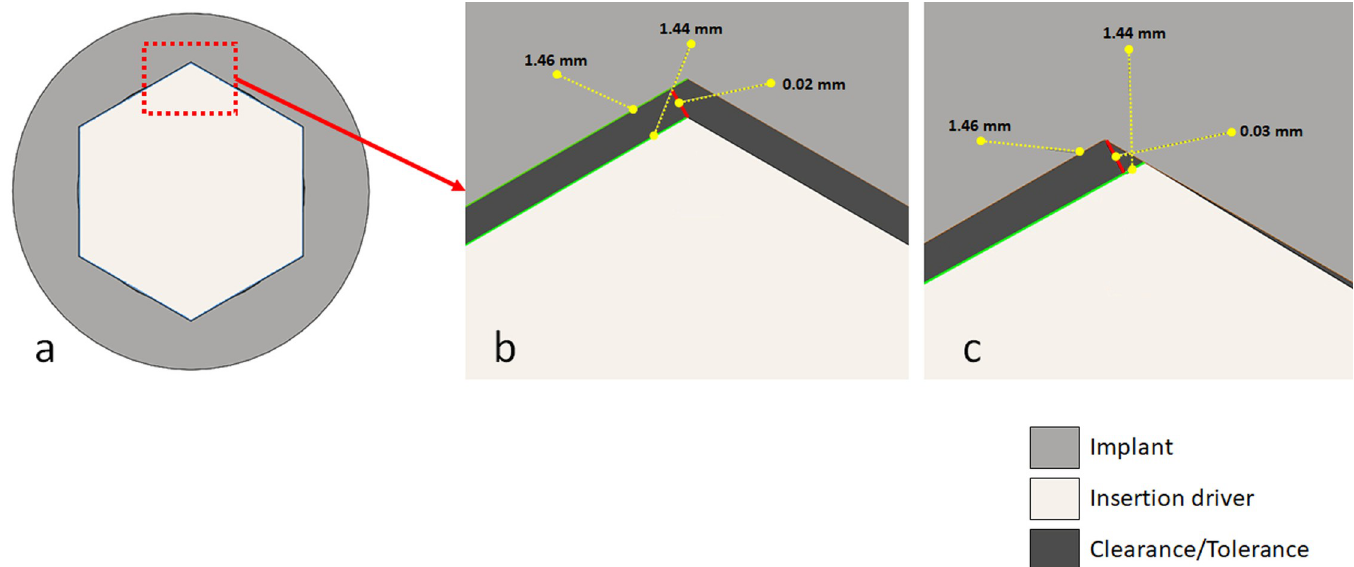
Fig 2. Schematic image of the project design: (a) insertion driver coupled in the implant; (b) space (clearance/tolerance) between the implant and the insertion driver after coupling; (c) the movement generated after the insertion driver rotation to apply the torque.